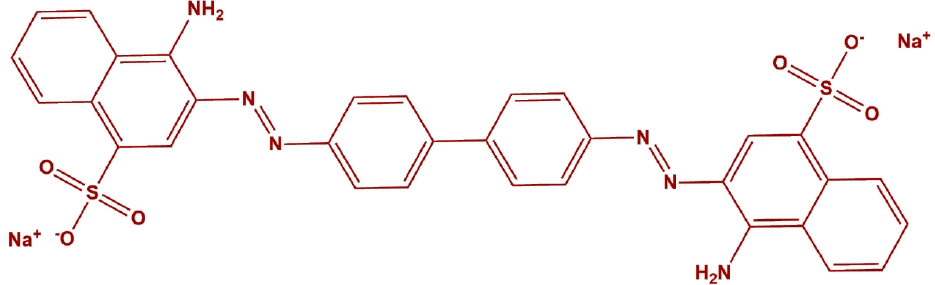
Figure 1. Chemical Structure of the CR dye.